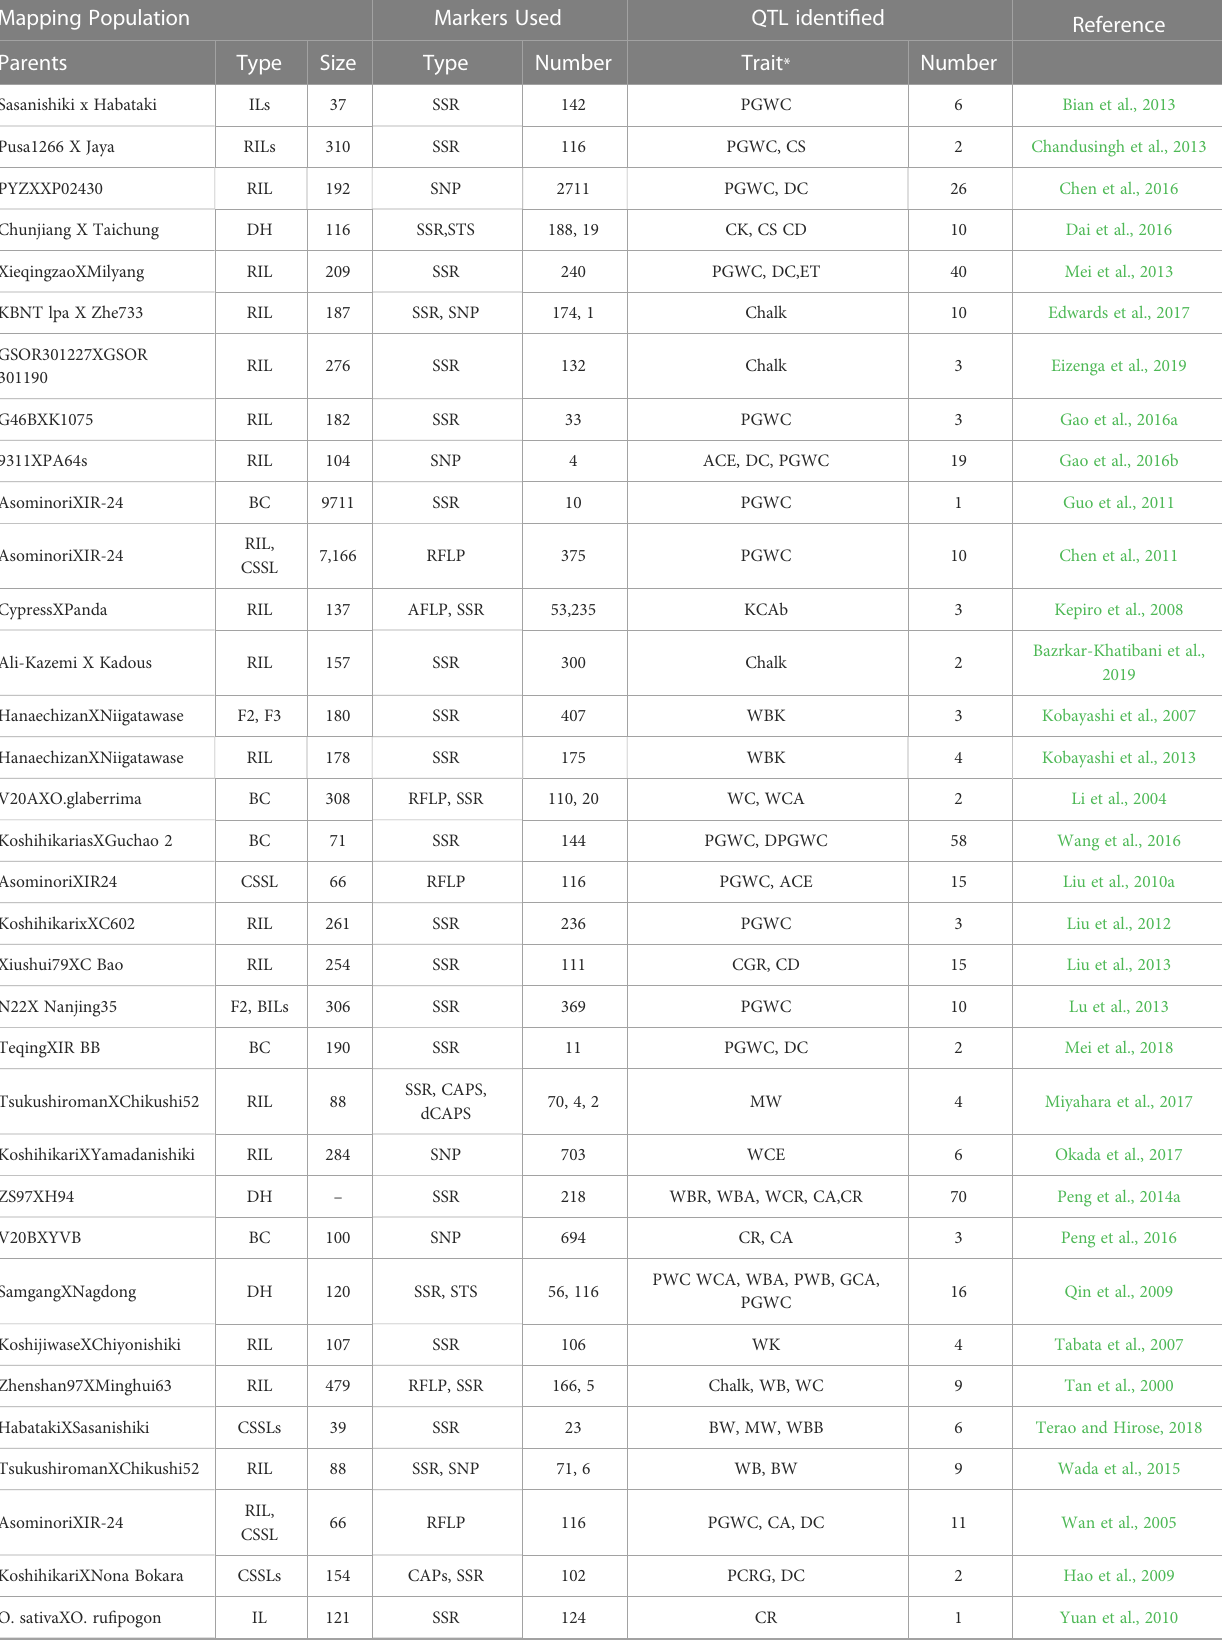
TABLE 1 Summary of the grain chalkiness QTL mapping studies in rice used to perform the